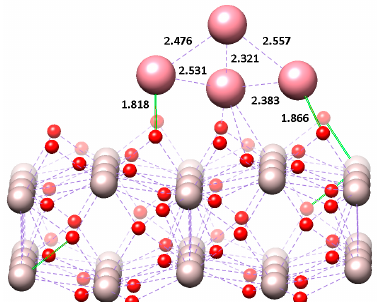
Figure 2. The optimized structure of Co 4 /Al 2 O 3 systems (colors: red — oxygen atom, grey — alumina atoms, violet — cobalt atoms); key distances are given in Å